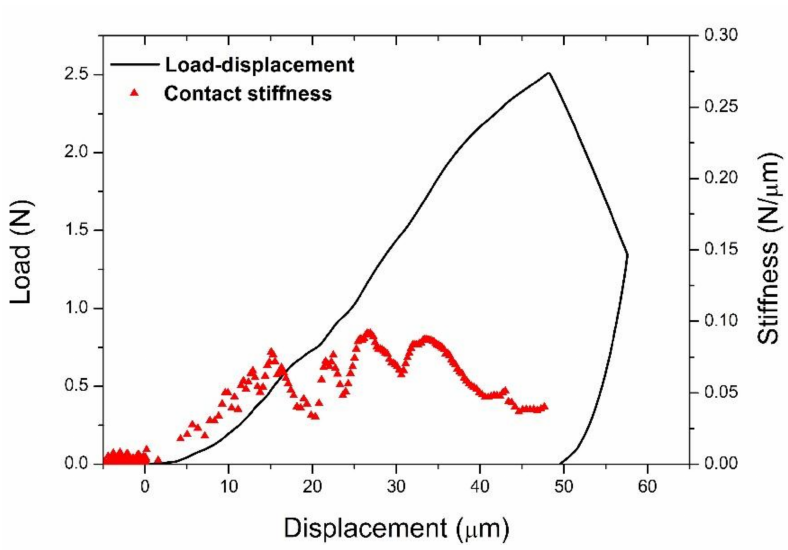
Figure 5. The load-displacement curve of the full indentation and variation of the contact stiffness during the loading segment. The load drop during the hold stage is